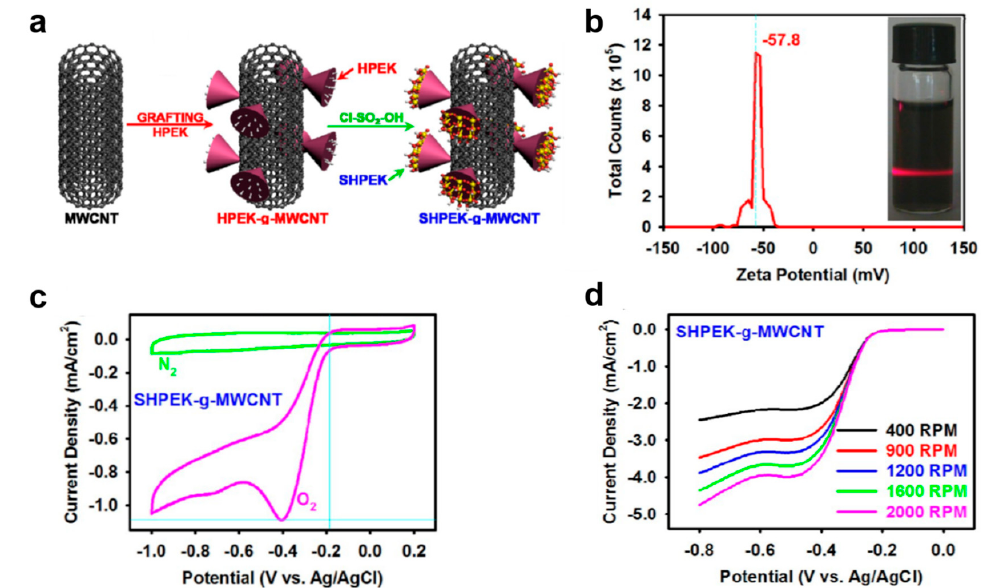
Figure 8. ( a ) Schematic demonstrations for SHPEK-g-MWCNT. ( b ) Zeta-potential curve of SHPEK-g-MWCNT (Inset: a photograph of the solution with hand-held laser shining). ( c ) Cyclic voltammograms in nitrogen- and oxygen-saturated 0.1 M aqueous KOH solution for SHPEK-g-MWCNT. ( d ) RDE voltammograms in oxygen-saturated 0.1 M aq. KOH solution with a scan rate of 0.01 V/s at different rotation rates. Reproduced from [131] with permission from the American Chemical Society.